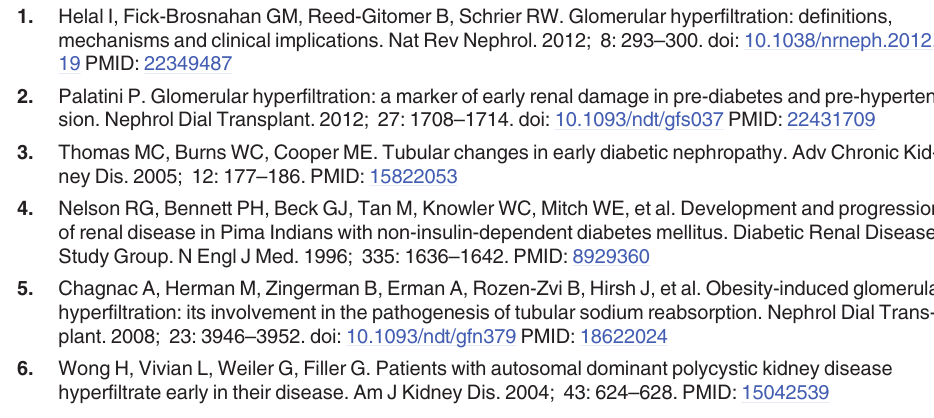
S1 Table. Estimated glomerular filtration rate stratified by age according to alkaline phos- phatase quartiles. The highest ALP quartiles showed higher prevalence of increased eGFR ( (cid:1) 130 ml/min/1.73m 2